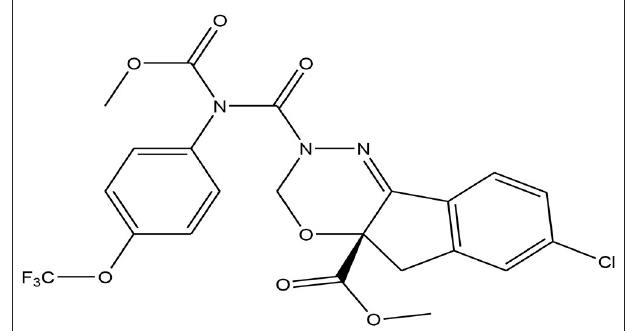
FIGURE 1 | Chemical structure of